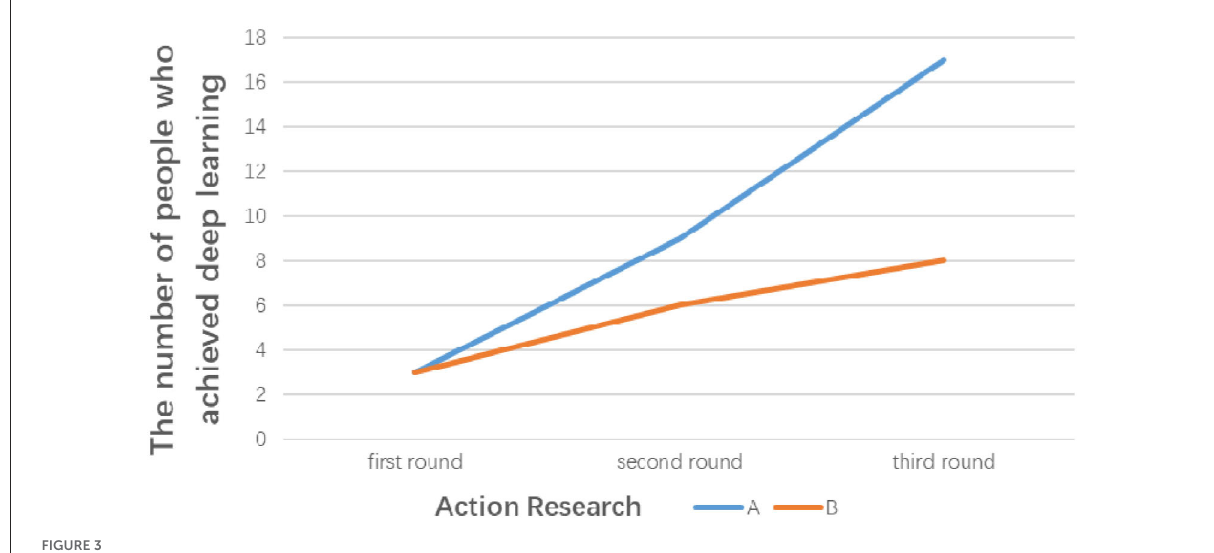
FIGURE3 The number of people who achieved deep learning in the three rounds of action research.